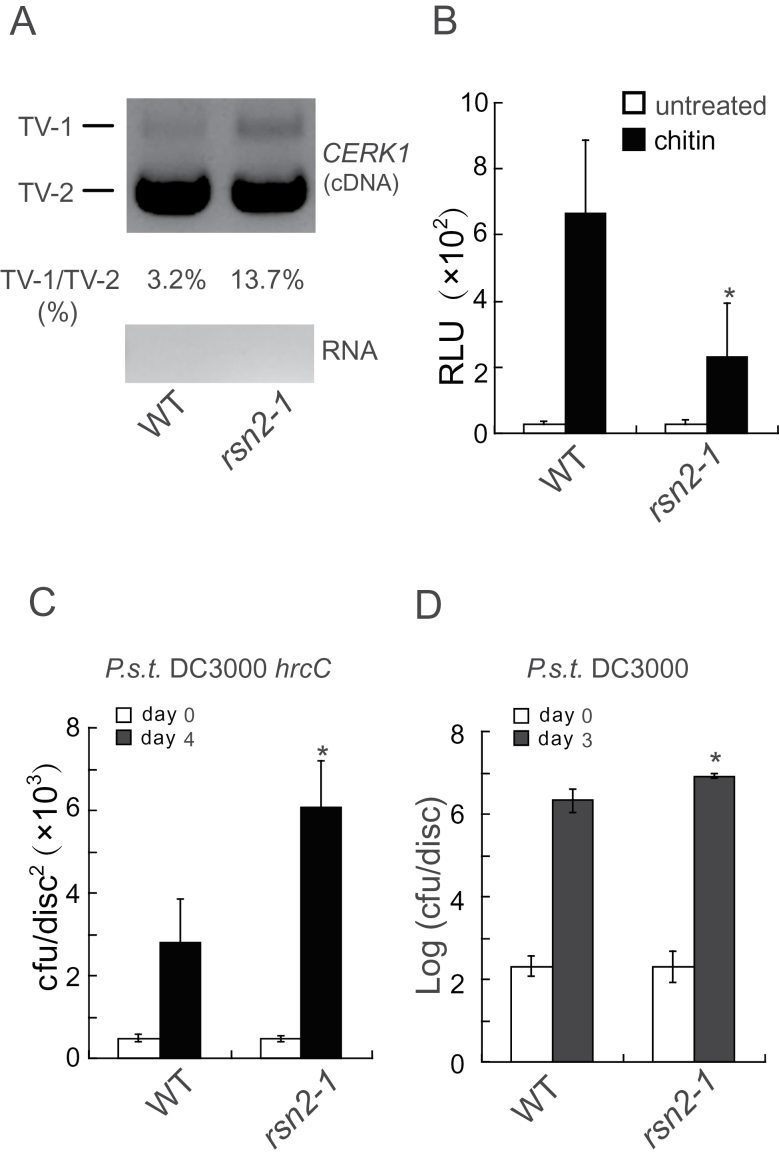
RSN2 Is Required for Alternative Splicing of CERK1 and PAMP-Triggered Immunity.
(A) Splicing patterns of CERK1 in wild-type and rsn2-1 plants. The primers flanking the first intron were used to amplify a fragment of CERK1 using cDNA or RNA as templates.
(B) Chitin-induced ROS burst in wild-type and rsn2-1 plants. Four-week-old soil-grown plants were used in the assay. Error bars represent standard deviations of 12 repeats. Asterisks indicate significant difference from wild-type (P < 0.001).
(C, D) Growth of P.s.t. DC3000hrcC (C) or P.s.t. DC3000 (D) in wild-type and rsn2-1 plants. Four-week-old soil-grown plants were challenged with P.s.t. DC3000hrcC (OD600 = 0.001) or P.s.t. DC3000 (OD600 = 0.0002). Bacterial titers were determined by plating leaf extracts on LB plates. Error bars represent standard deviations of six repeats. Asterisks above the bars indicate significant difference from wild-type. P < 0.001 (C); P < 0.01 (D).